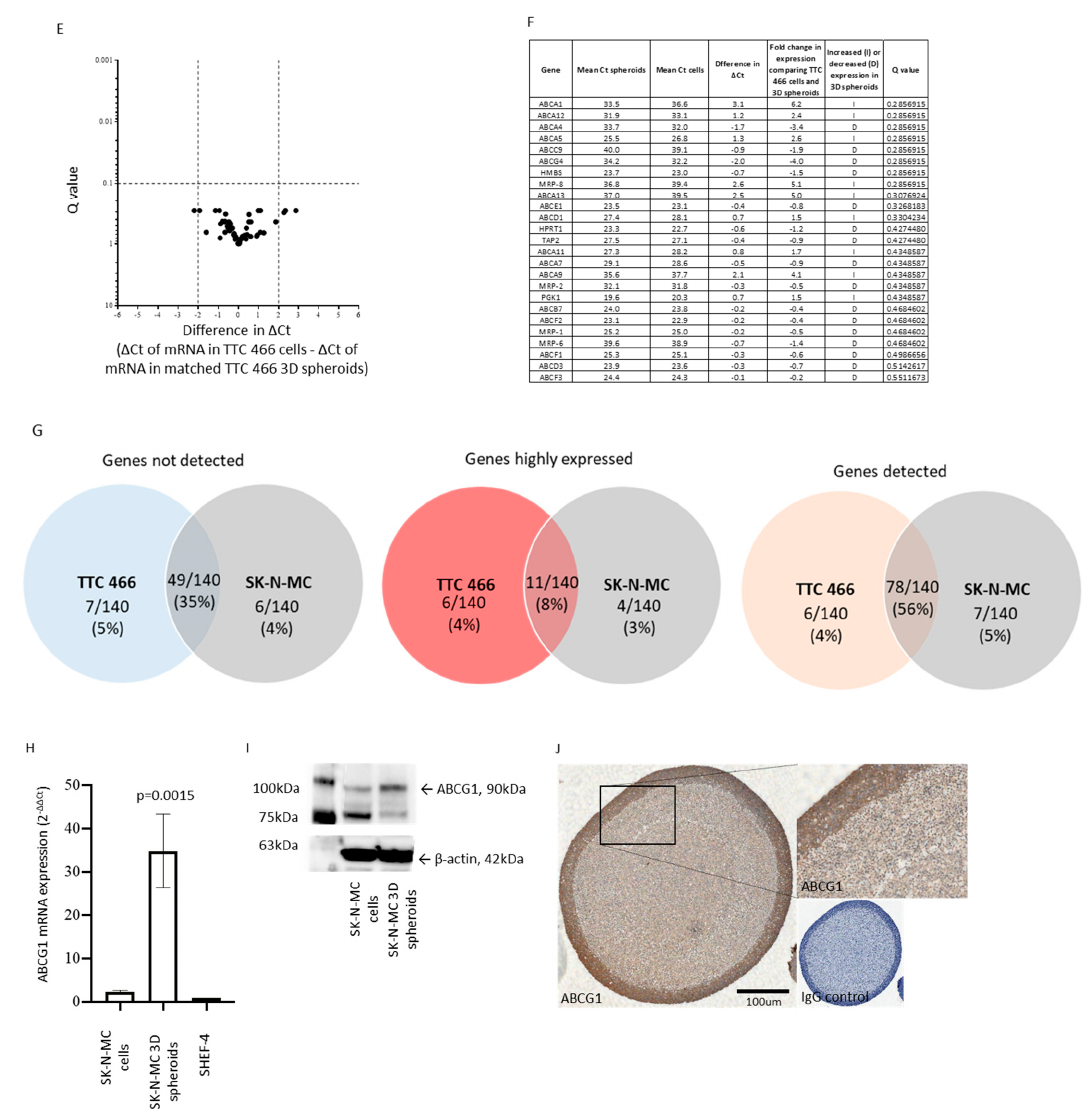
Figure 4. Expression of ABC transporter proteins by SK-N-MC and TTC 466 cells in 2D and 3D spheroid cultures. RNA (1 µ g) from ( A ) SK-N-MC and ( D ) TTC 466 cells in 2D and 3D cultures were analysed by RTqPCR using the TaqMan ® Human ABC Transporter Array. The level of mRNA expression was reported using the comparative Ct method as mean ± SEM, after normalisation of target Ct values to the global mean of all mRNAs. Results are the mean of two independent experiments. * = Genes with change in ∆ Ct > 2 and Q value < 0.1 comparing SK-N-MC cells in 2D and 3D cultures. Genes with Ct values of >35 in SK-N-MC cells grown in 2D were excluded. Volcano plot summarising the differentially expressed ABC transporter mRNAs in ( B ) SK-N-MC and ( E ) TTC 466 2D and 3D spheroids, displaying the Q value (level of significance) and the difference in ∆ Ct between the cells in 2D and 3D spheroids. The vertical dashed lines indicate the ∆ Ct thresholds of +/ − ∆ Ct of >2 ( x -axis) and the horizontal line a significant Q value < 0.1 ( y -axis). Black square = CFTR which was significantly decreased and black triangle = ABCG1 which was significantly increased in 3D spheroids compared to 2D cultures. Black circles = ABC transporter proteins with a ∆ Ct of ± <2. The differentially expressed genes all have a Q value < 0.1. Mean Ct values of ABC transporter mRNAs in ( C ) SK-N-MC and ( F ) TTC 466 cells grown in 2D and 3D, the difference in ∆ Ct between the two groups and corresponding Q values are shown. Grey = genes with change in ∆ Ct > 2 and Q value < 0.1. ( G ) ABC transporter and pluripotency mRNAs ( n = 140) detected